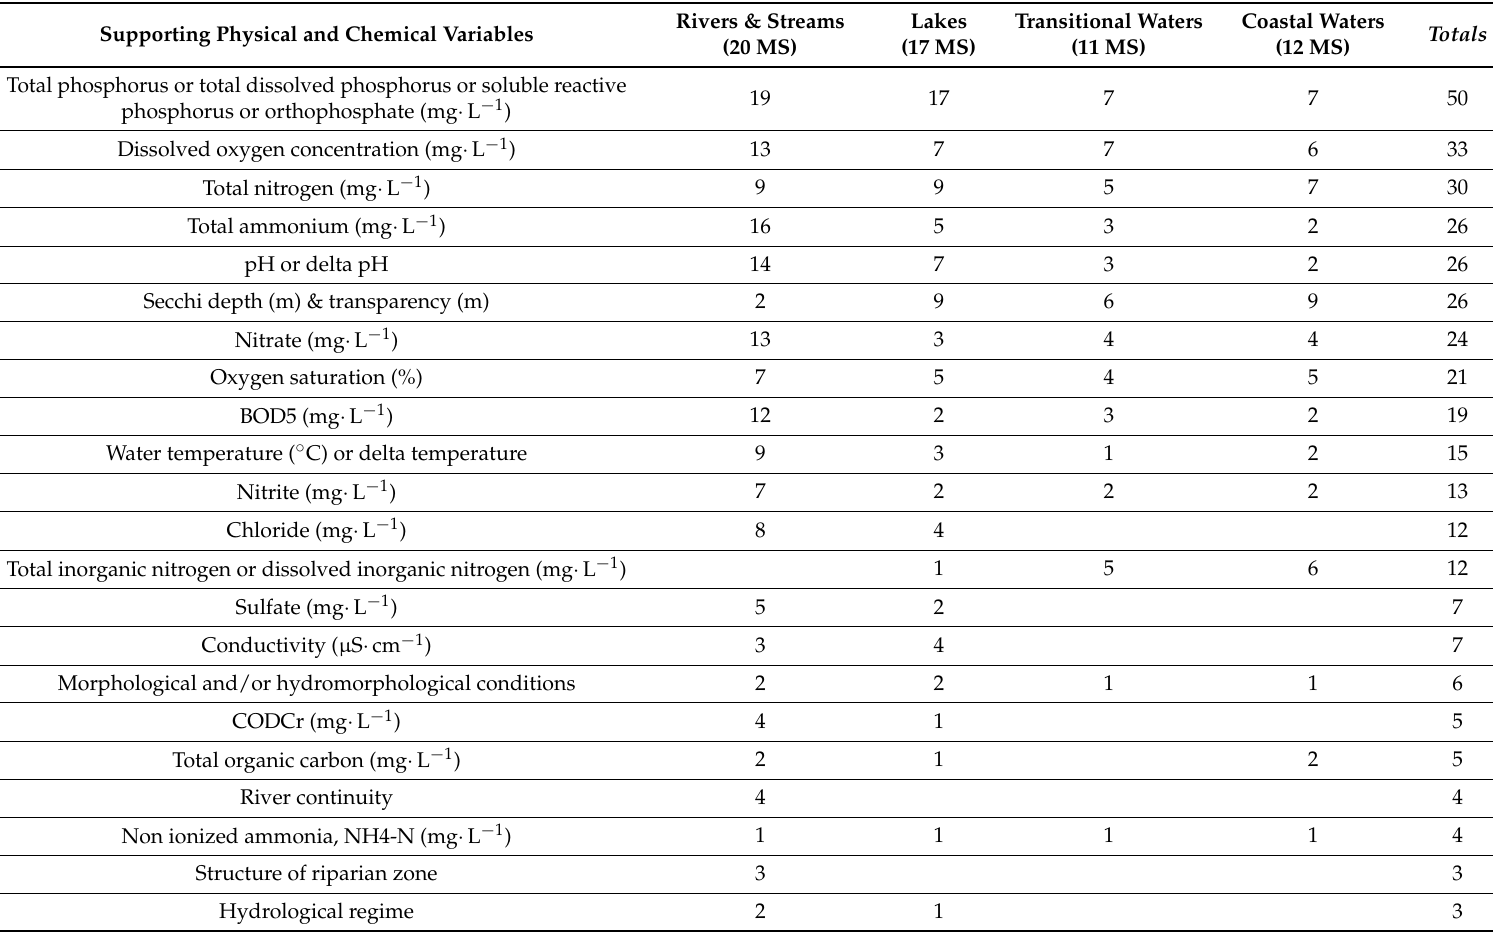
Table 3. Overview of supporting physical and chemical quality elements used by the EU Member States (MS). Source: modified after Claussen et al. 2011 [21]. Numbers indicate the total number of MS (a total of 20 MS were included in the analysis) that reported good-moderate boundary values for variables for different surface water categories. Missing numbers imply that good-moderate boundary values were not defined (the variable was not used in monitoring) or not reported for this